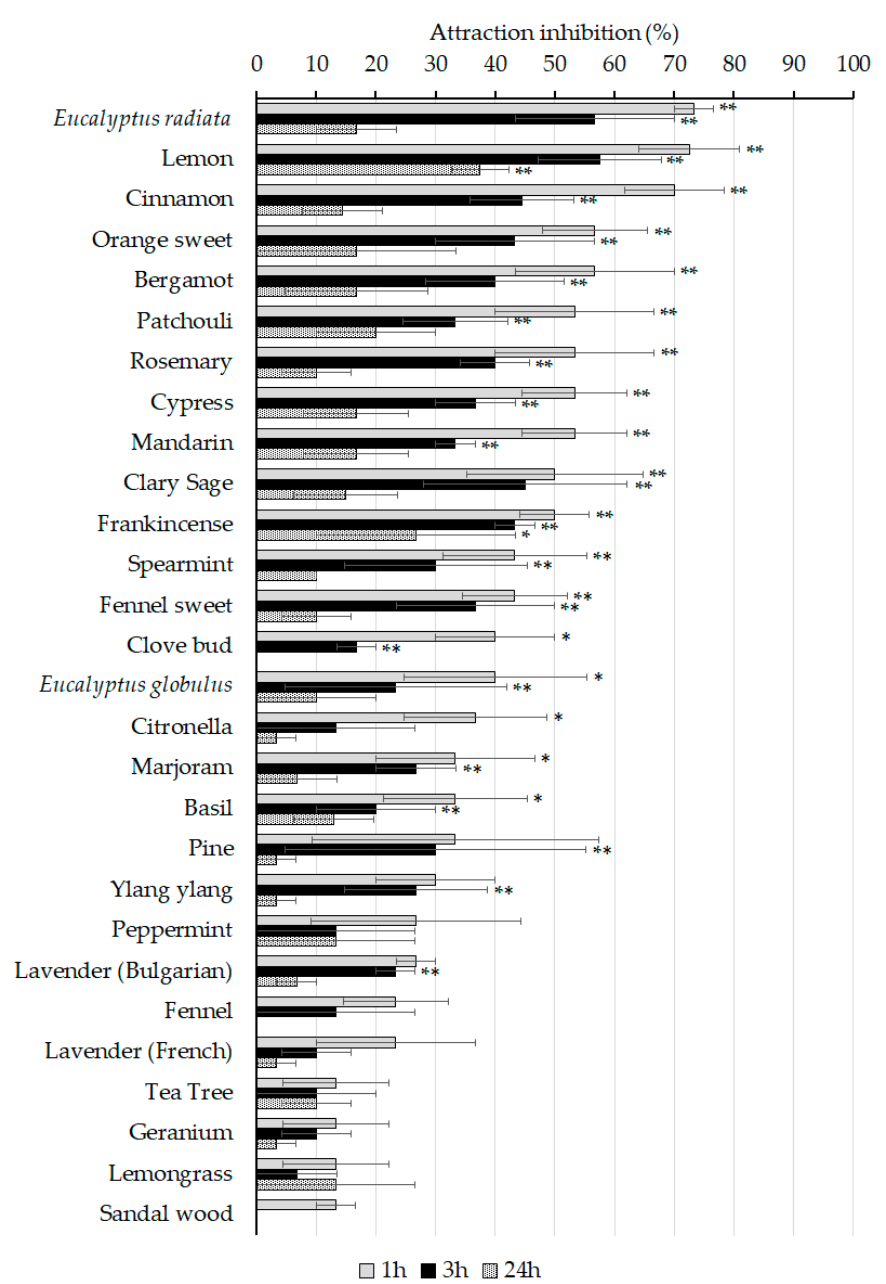
Figure 2. Attraction–inhibition activity. Control attraction–inhibition at 1, 3, and 24 h were 12.9 ± 4.3, 2.9 ± 1.7, and 7.1 ± 3.2%, respectively. Asterisks denote significant di ff erences between the control repellency at p < 0.05 (*) and p < 0.01 (**) in one-way ANOVA followed by the Tukey’s b test. Over time, the attraction–inhibition e ff ect of the active oils diminished, possibly due to either the evaporation of the oils through the opening of the test chamber or the loss of concentration gradient in the air of test tubes. Whereas 18 and 20 oils showed significant inhibitory activity at 1 and 3 h post-treatment ( p < 0.05), only frankincense and lemon oils displayed moderate activity ( > 40%) after 24 h of